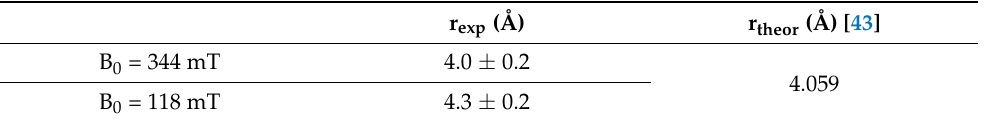
Table 3. Distance between calcium and phosphorus as derived from the analysis of ESEEM peaks exploiting Equation exploiting Equation (3).